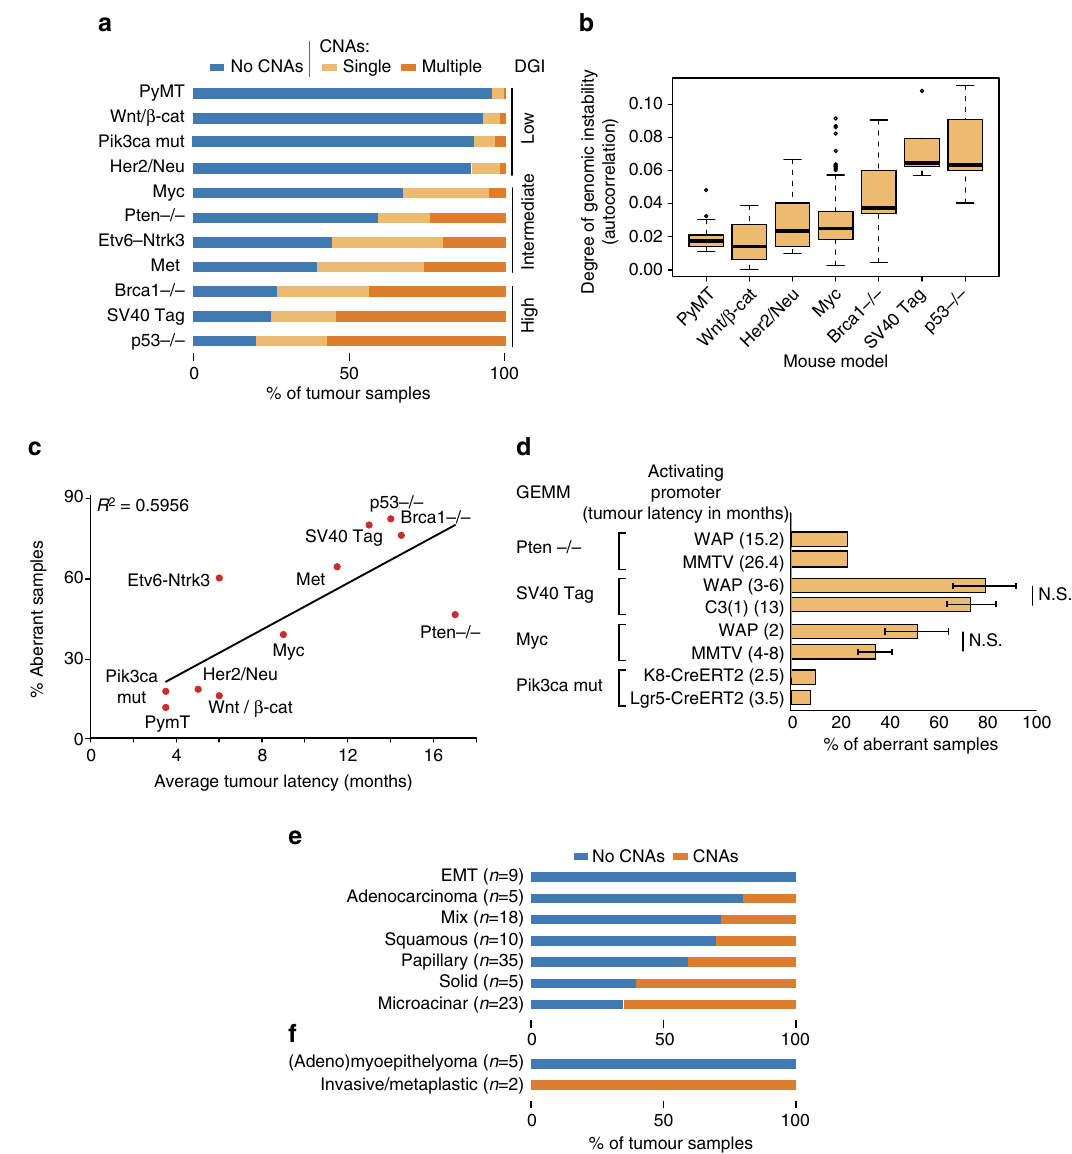
Figure 3 | Driver-specific degree of genomic instability in breast cancer GEMMs. ( a ) The degree of genomic instability (DGI) differs considerably between breast cancer GEMMs. Presented is a quantification of CNA prevalence in the 11 most common GEMMs for which data were available from 4 20 samples from at least two independent studies. The Brca (cid:2) / (cid:2) , Pten (cid:2) / (cid:2) and Met models represent both p53 þ / þ and p53 þ / (cid:2) backgrounds. Single, 1 CNA detected; multiple, 4 1 CNA detected. ( b ) The degree of genomic instability, as estimated by autocorrelation between proximate genes, in the Affymetrix mouse genome 430A 2.0 array. Note that the different DGI measures in a and in b result in the same GEMM ranking. Boxes show the median, 25th and 75th percentiles, lower whiskers show data within 25th percentile (cid:2) 1.5 times the IQR, upper whiskers show data within 75th percentile þ 1.5 times the IQR and circles show outliers. ( c ) A correlation between DGI and average tumour formation latency across GEMMs. Average tumour latencies depend on the activating promoters, and represent either MMTV (for Myc, PyMT, Her2/Neu, Wnt/ b cat and Met), WAP (for SV40Tag and Etv6–Ntrk3) or Lgr5 (for Pik3ca_mut). ( d ) DGI is inherent to the driver gene, regardless of the promoter used for its activation/perturbation, and regardless of tumour latency within the GEMM. NS, not significant (Student’s t -test). Bar plots represent the mean ± s.d. ( e ) A significant difference in the DGI of histologically distinct tumours (GSE15904) induced by Myc in mice that share the same genetic background, when using the same promoter for Myc activation. ( f ) A significant difference in the DGI of histologically distinct tumours (GSE69290) induced by mutated Pik3ca in mice that share the same genetic background, when using the same promoter for mutated Pik3ca activation. See also Supplementary Figs 5 and models (PyMT, Wnt/ b cat, Pik3ca_mut and Her2/Neu) primarily DGI 17 . We found that DGI markedly differed between breast gave rise to diploid tumours, and almost never developed cancer GEMMs ( P o 10 (cid:2) 16 , w 2 -test of independence), with the prevalence of large CNAs ranging from B 4% to B 80% of the tumours with more than one CNA (Supplementary Fig. 5). The tumours ( 4 17-fold difference, for the PyMT and p53 (cid:2) / (cid:2) other four models (c-Myc, Pten (cid:2) / (cid:2) , Etv6–Ntrk3 and Met) showed intermediate prevalence of chromosomal aberrations. As models, respectively; Fig. 3a). The three most unstable models expected, not only was p53 (cid:2) / (cid:2) the least stable model, but p53 (p53 (cid:2) / (cid:2) , SV40Tag and Brca1 (cid:2) / (cid:2) ) often harboured multiple chromosomal aberrations per tumour. In contrast, the most stable status ( þ / þ or þ / (cid:2) ) was also a predictor of genomic instability